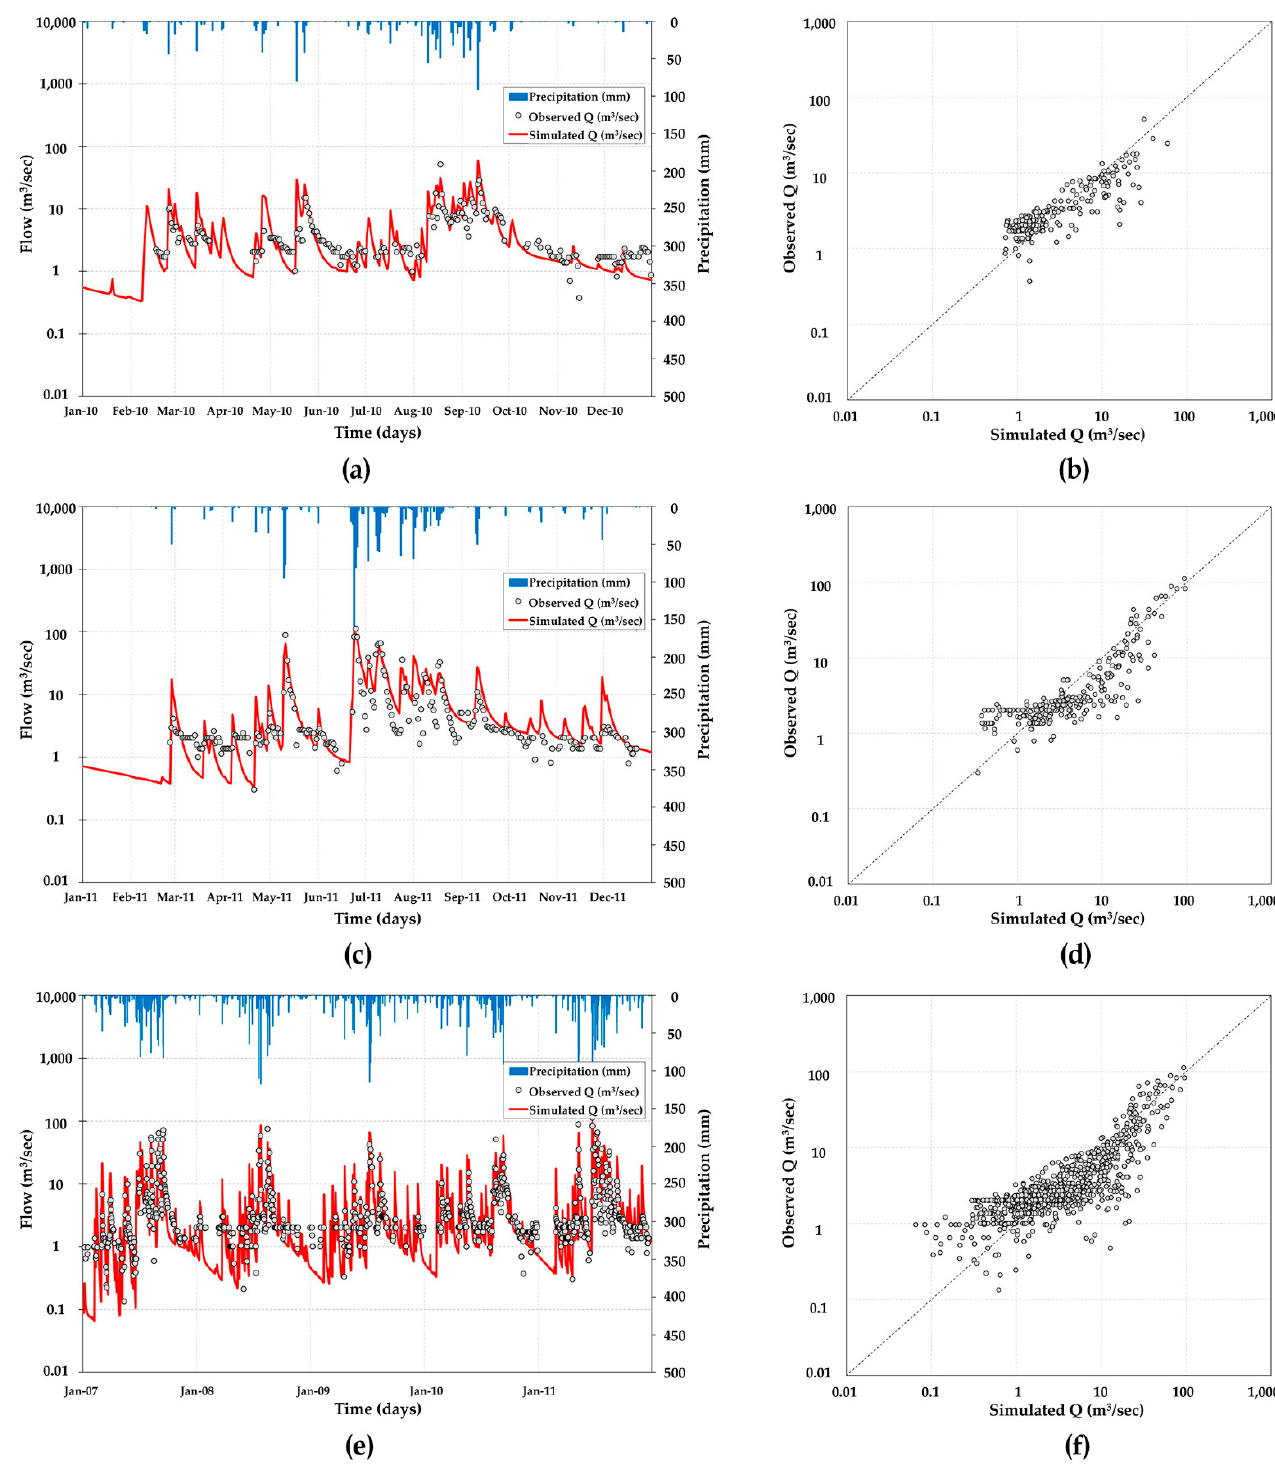
Figure 9. Soil and Water Assessment Tool (SWAT) validation results of Yecheon Bridge (2010, 2011, 2007–2011): ( a ) validated hydrograph (2010); ( b ) scatterplot (2010); ( c ) validated hydrograph (2011); ( d ) scatterplot (2011); ( e ) calibrated and validated hydrograph (2007–2011); ( f ) scatterplot (2007–2011).